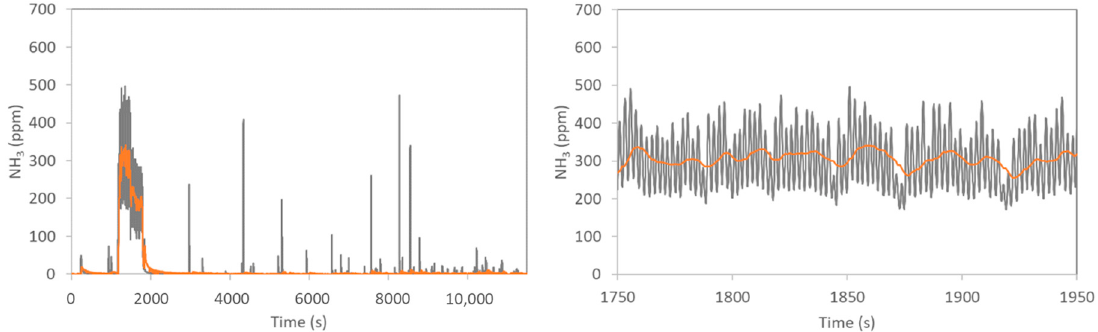
Figure 7. NH 3 emission profiles measured during an on-road test using the OBS-ONE-XL (grey) and the PEMS-LAB (orange) over the real driving conditions.